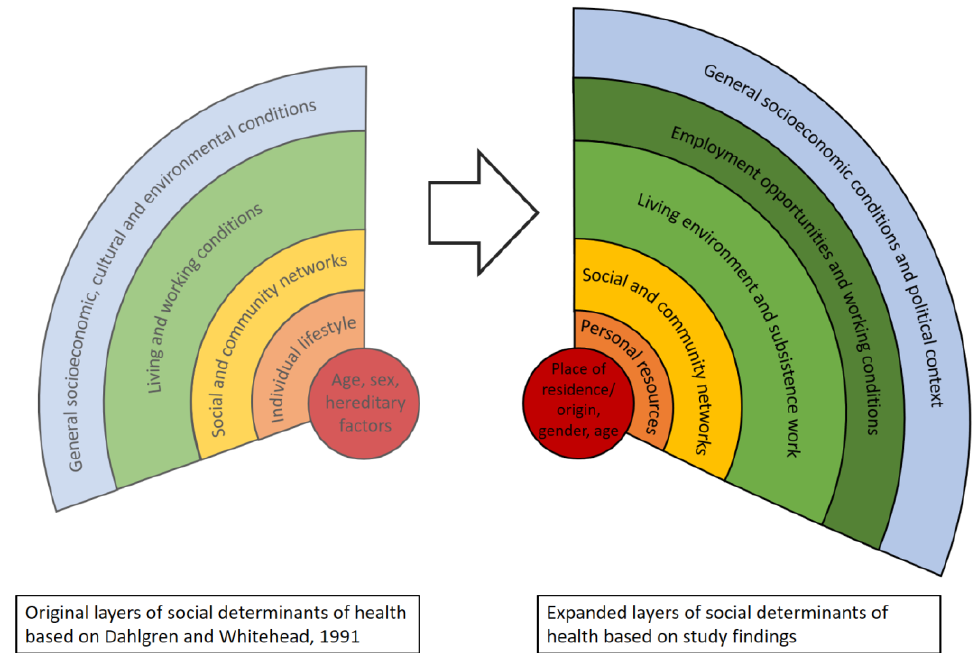
Figure 3. Layers of social determinants of health. Contrasting layers of inequities from the original model (Dahlgren and Whitehead, 1991; left ) and expanded model based on the perception of communities affected by industrial mining projects (our own data; right ).